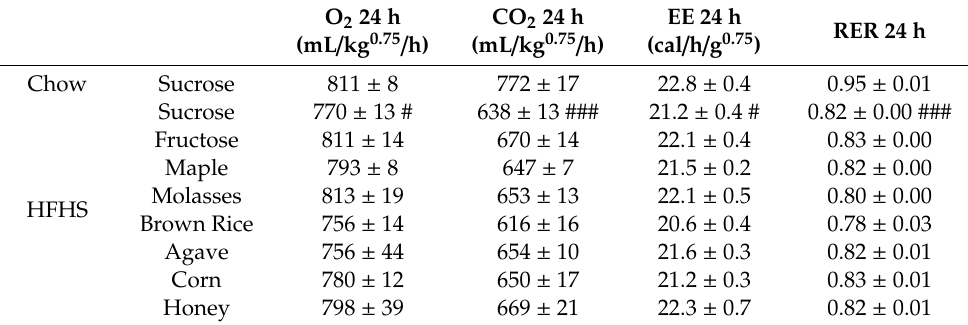
Table 2. E ff ects of refined sugars and natural sweeteners on respiratory exchange